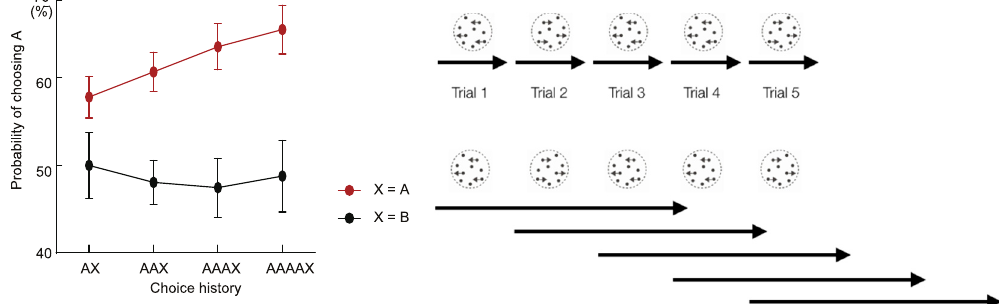
Figure 2. Behavioral Manifestations of Multiple Temporal Scales of Computations. The left panel shows the choice patterns across multiple trials. The x -axis indicates the number of repetitions of the same choice (A). The last trial (X), in the sequence AX, AAX, etc. on the independent axis in the figure, can be either A (repetitions of the same choices in the last trial) or B (the alternative in the last trial). The y -axis shows the probability of choosing A in the current trial. The right panel displays the scheme of multiple temporal scales in perceptual decision making, with two possible models. The black lines below the pictures of the stimuli of random dot motions indicate the e ff ective length of computations. In the upper panels, the e ff ective length is confined within a single trial (the model where each trial is independent), whereas the lengths in the lower panels are extended beyond the windows of single trials (the model where longer timescale choice bias exists). The plot on the left indicates that prior choices strongly bias future choices for the same task in the same environment, following the lower model. (Left image adapted with permission from Akaishi et al., 2014, Neuron, Cell Press